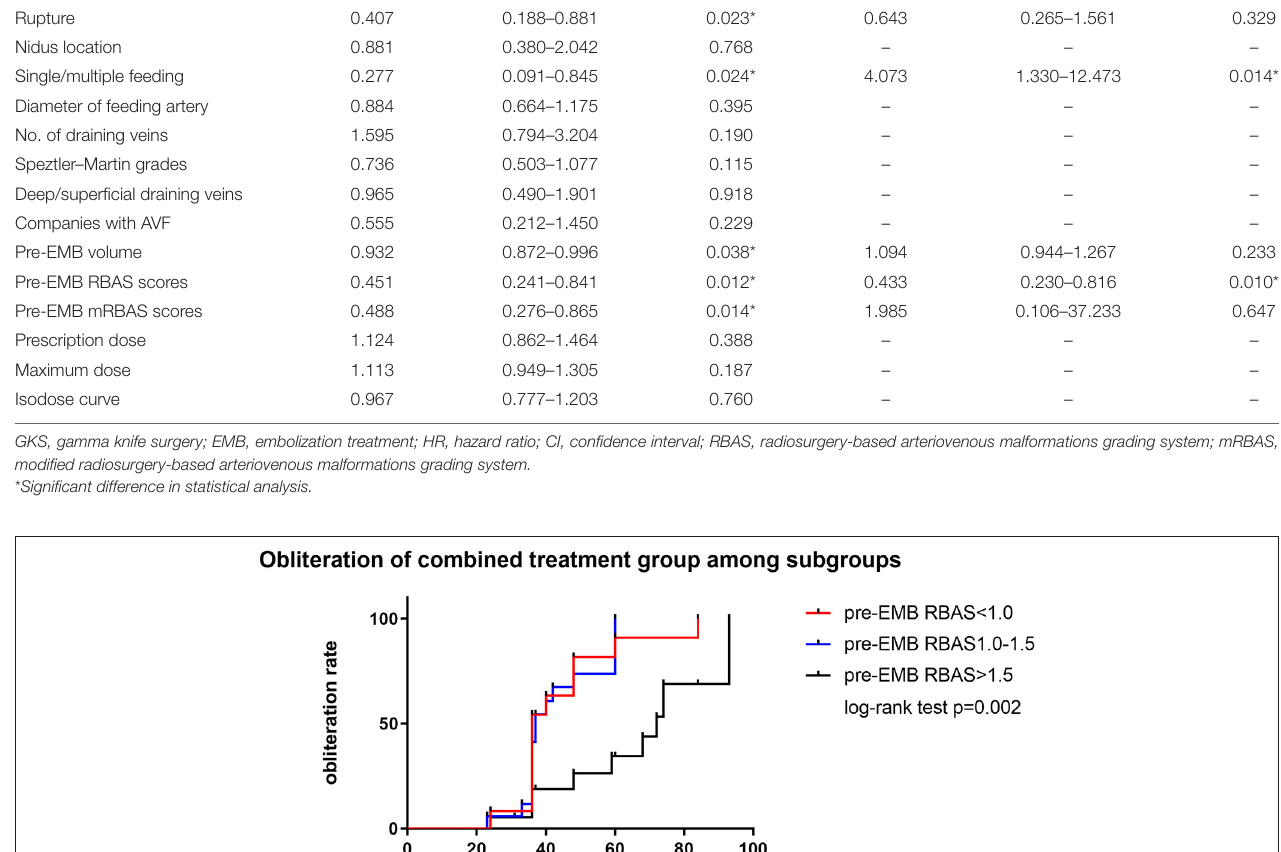
difference between obliteration and non-obliteration patients ( p < 0.01) in the GKS group, indicating that as the RBAS increases, the obliteration